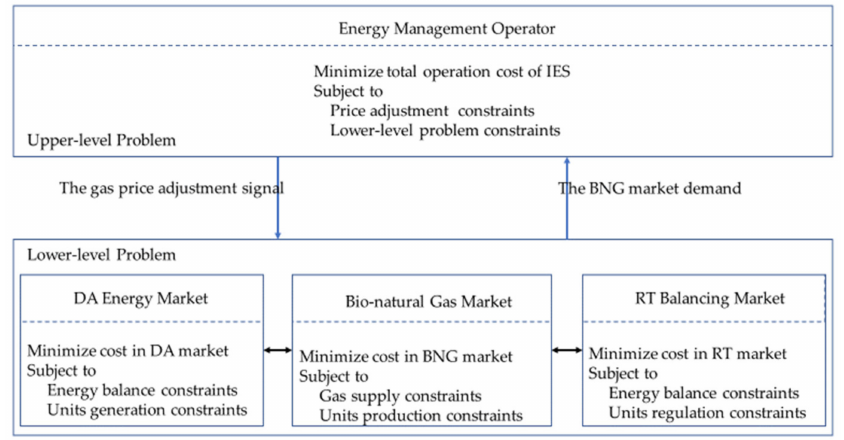
Figure 2. The framework of the open energy market. IES, integrated energy